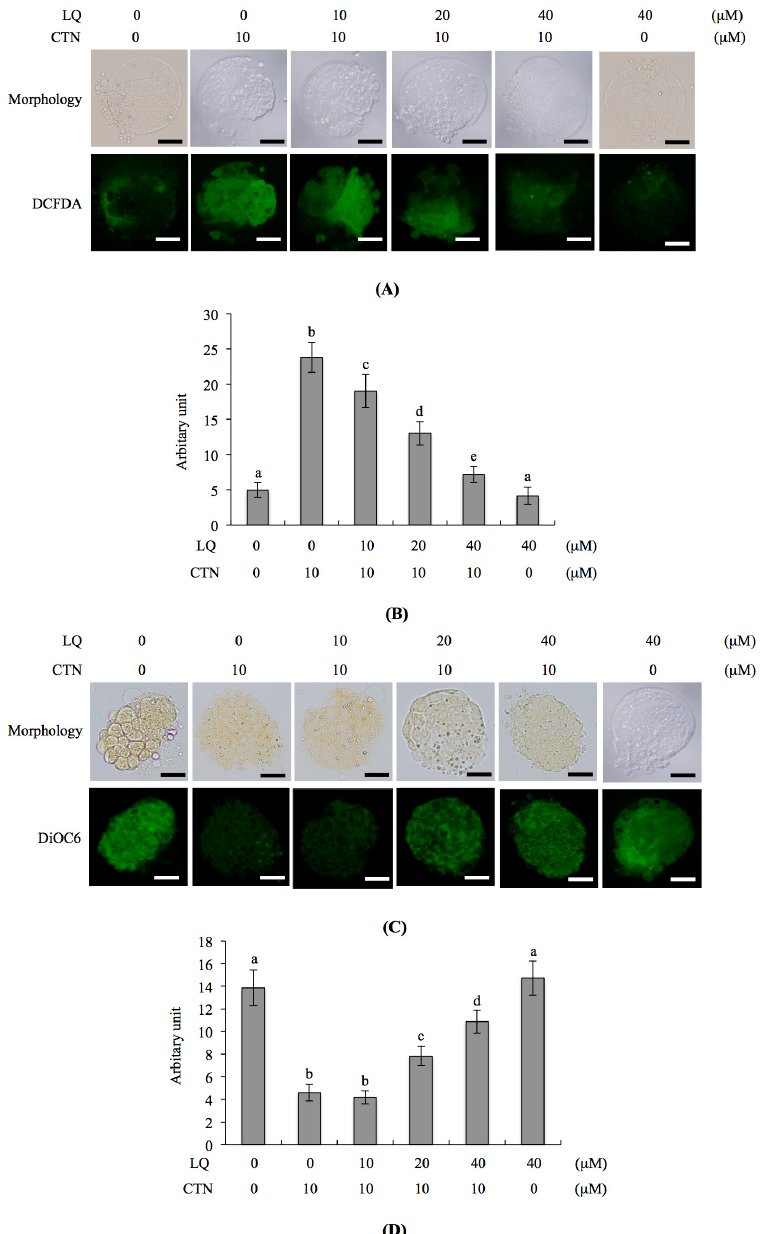
Figure 4. Effects of LQ on CTN-induced reactive oxygen species (ROS) generation and loss of mitochondrial membrane potential in mouse blastocysts. ( A ) Mouse blastocysts were preincubated with LQ (10–40 μ M). After 1 h, embryos were further treated with or without 10 μ M CTN for a further 24 h. ( A ) DCF-DA (2 ′ ,7 ′ -dichlorodihydrofluorescein diacetate) fluorescence dye (20 μ M) was used to detect intracellular ROS generation; ( B ) Quantitative analysis of intracellular ROS production in each group was conducted using image J software; ( C ) Embryos were incubated with 40 nM DiOC6(3) at 37 °C for 1 h and mitochondrial membrane potential (MMP) changes examined. MMP was analyzed under a fluorescence microscope; ( D ) Quantitative analysis of MMP changes in each group was conducted using image J software. The total blastocyst number was 160 for each group. Values are presented as means ± SD of five determinations. Different symbols indicate significant differences at p < 0.05. The scale bar is 20 μ m.